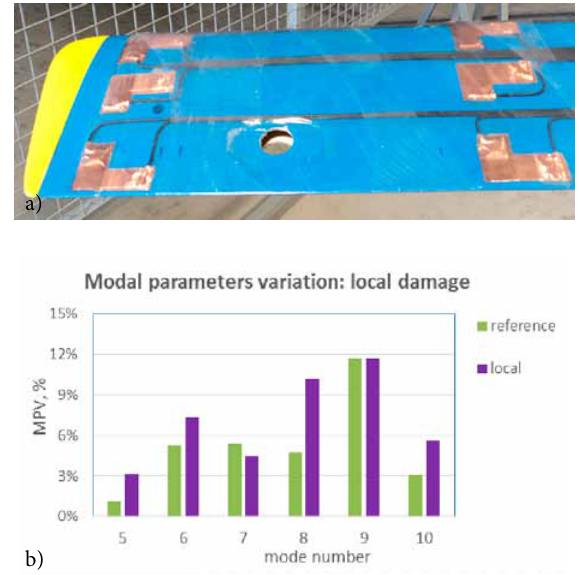
Fig. 7. Photo of the local damage of the blade model (a); local damage according to the modal parameter variation (b)